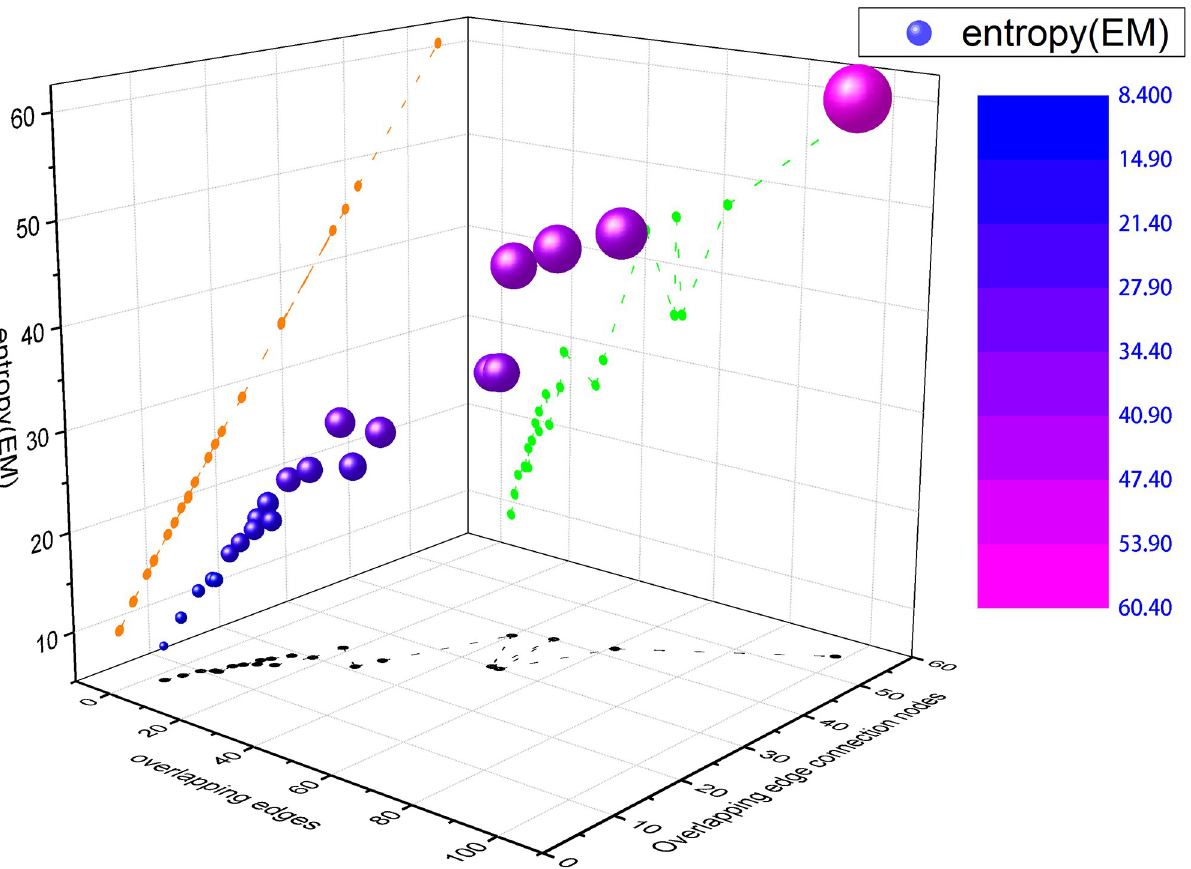
Fig 4. Three-dimensional coordinate scatter plot of aucs multiplex network. The green projection points reflect is the relationship between the overlapping edges and entropy of the combined layers. The orange projection points represent the relationship between the overlapping edge connected nodes and the entropy of the combined